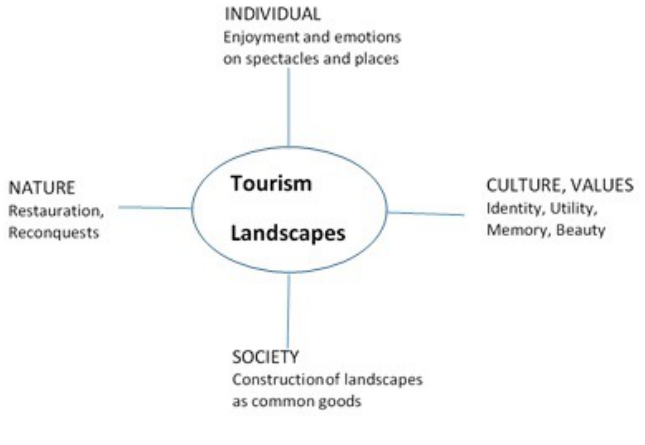
Figure 14: The four pole model for tourism